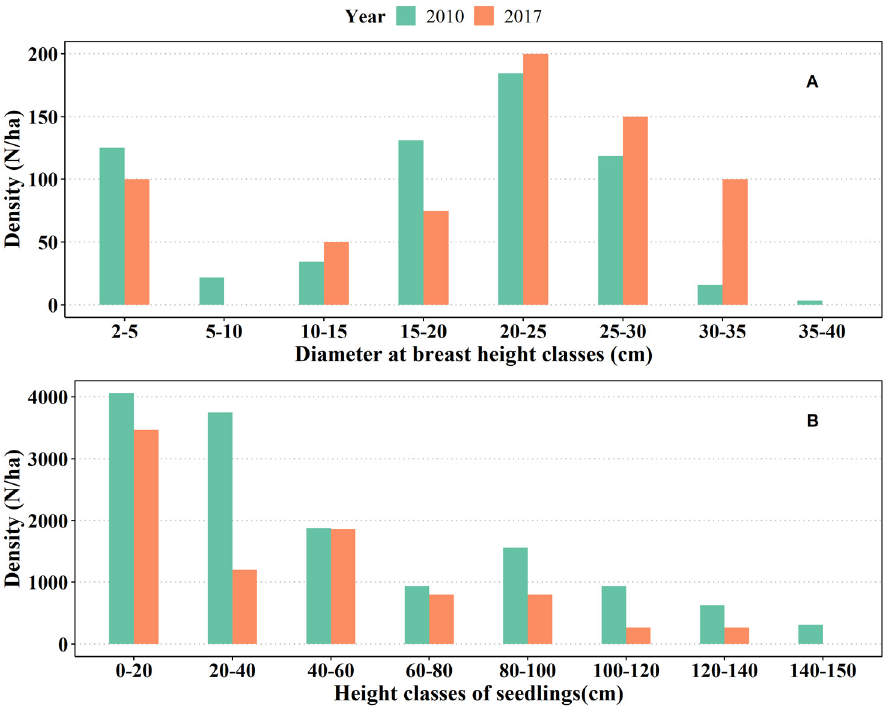
Figure 1. Distribution of diameter at breast height classes for adult trees ( A ) and distribution of height classes for seedlings ( B ) of Quercus acutissima in 2010 and 2017, respectively.